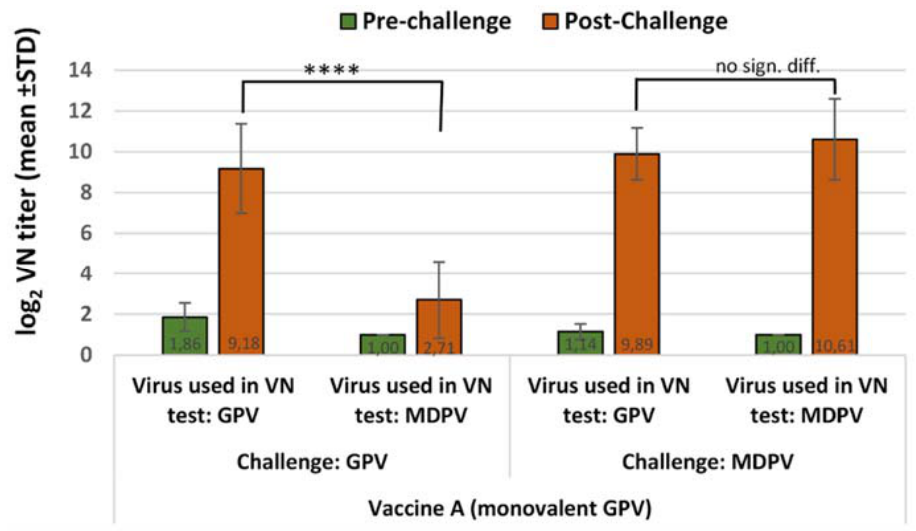
Figure 1. Humoral antibody response to GPV and MDPV in MDA ‐ free ducks, vaccinated with mon ‐ ovalent GPV vaccine then challenged with homologous or heterologous strains of WPV at 2 weeks of age. Statistical comparison of post ‐ challenge virus neutralization titers against GPV and MDPV indicate significant difference after GPV challenge (**** p < 0.0001), but no significant difference in the case of MDPV challenge infection ( p = 0.437).